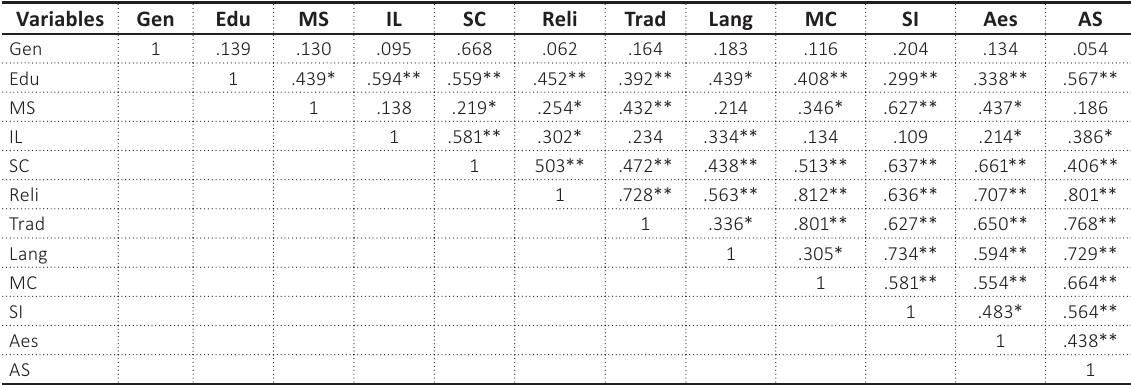
Table 3. Correlation matrix of demographics, cultural values and advertisement segmentation